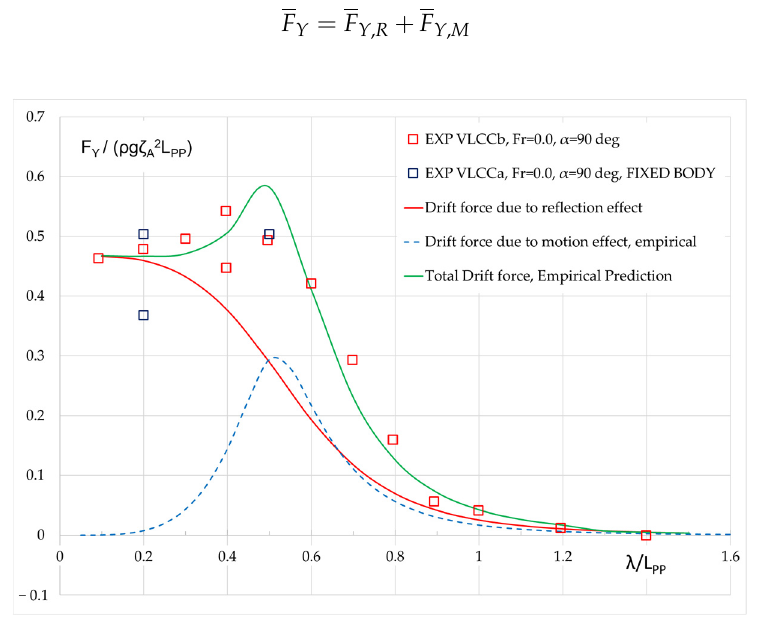
Figure 12. Empirical prediction of the mean sway force of a ship in regular head waves, Fr = 0.0.